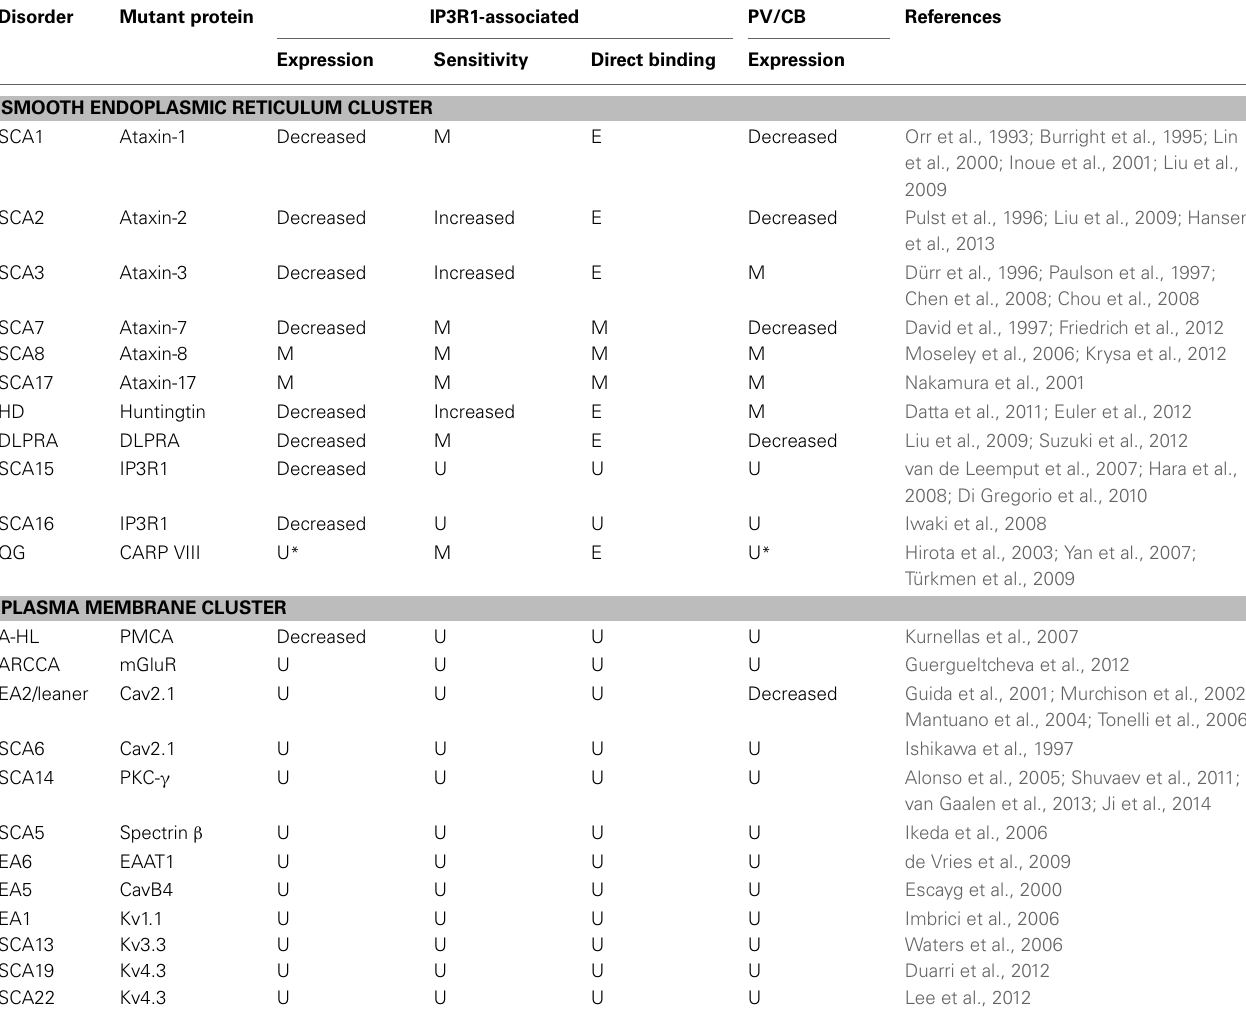
Table 1 | Neurological disorders in humans and mice involving IP3R1, calbindin (CB), parvalbumin (PV), and other calcium signaling proteins.